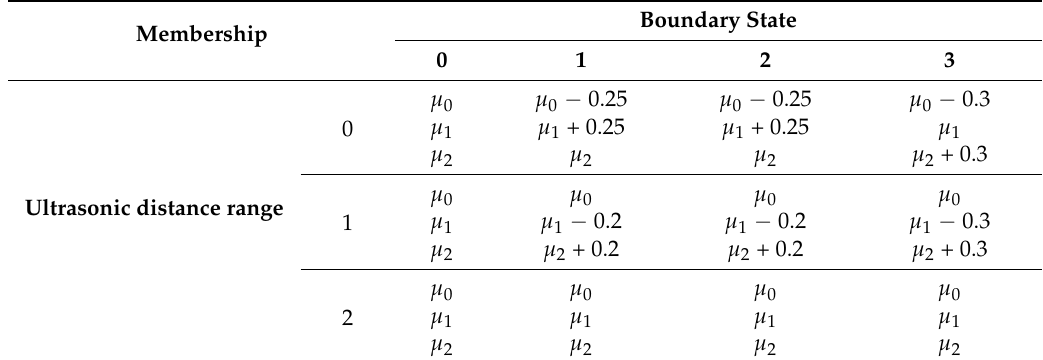
Table 4. Membership redefinition of ultrasonic distance